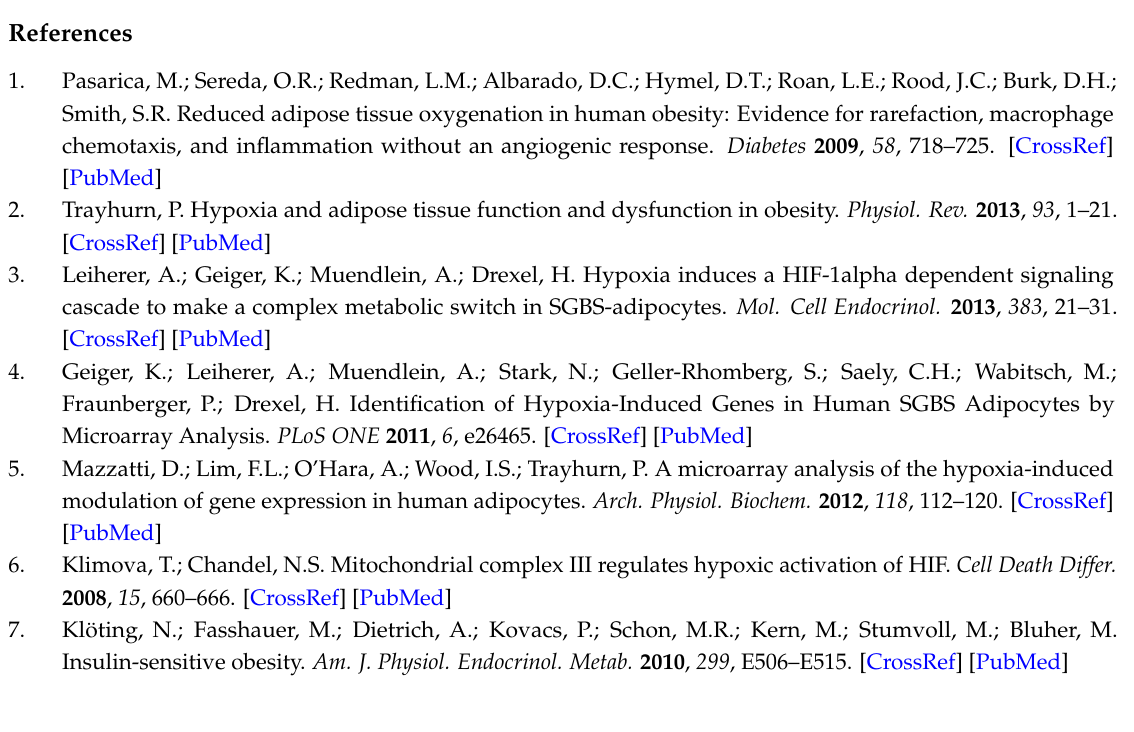
Table S1: Oligonucleotide sequences. All sequences are given in 5 1 -3 1 orientation, Table S2: Gene expression data according to qPCR